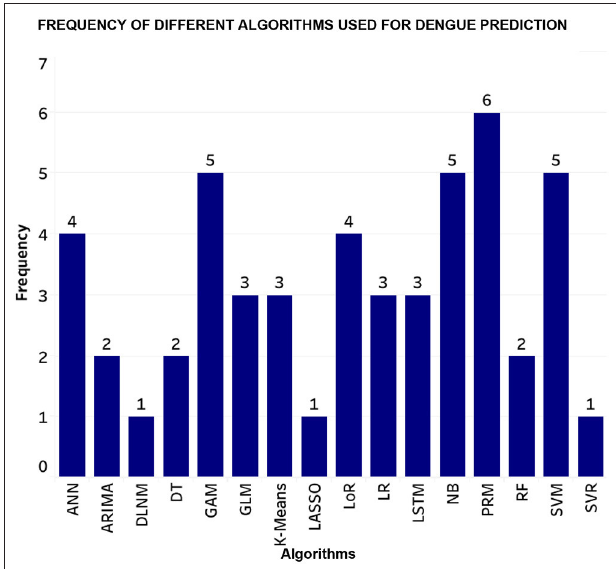
FIGURE 7 | Frequency of machine learning techniques used for dengue incidence prediction (SVM, Support Vector Machine; NB, Naive Bayes; DLNM, Distributed Lag Non-Linear Model; PRM, Poisson Regression Model; LSTM, Long Short Term Memory, ANN, Artificial Neural Network; GLM, Generalized Linear Model; GAM, Generalized Additive Model; LoR, Logistic Regression; LR, Linear Regression; RF, Random Forest; DT, Decision Tree; SVR, Support Vector